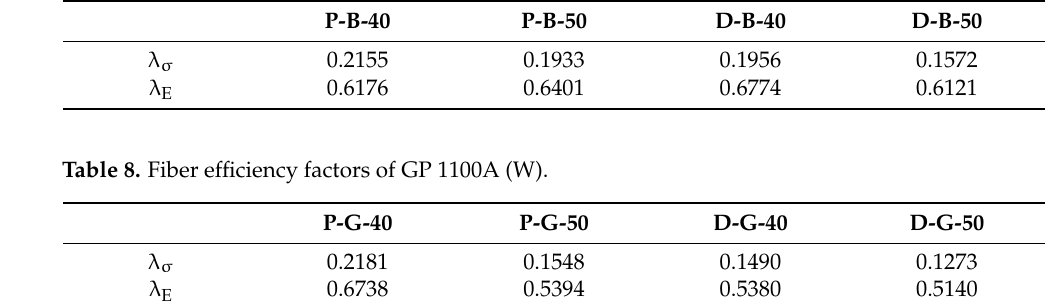
Table 7. Fiber efficiency factors of 1011 BRT.